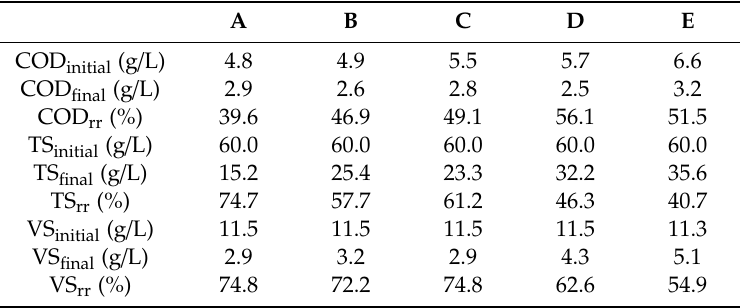
Table 4. Variations of TSs, VSs, and COD before and after the experiments under di ff erent ratios of kitchen waste and